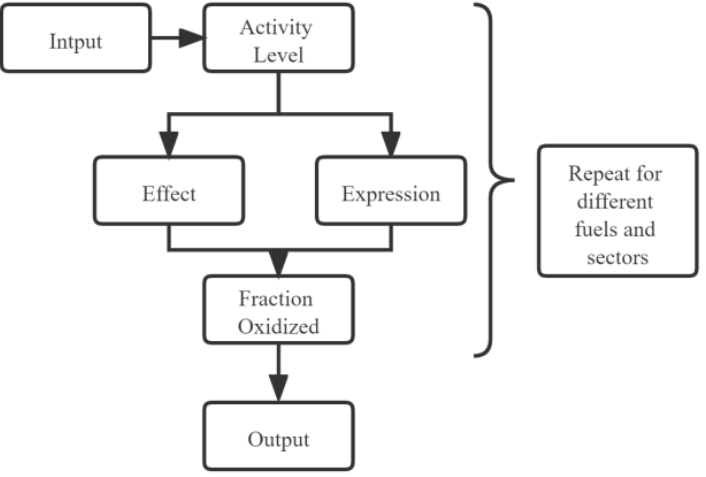
Figure 3. Application of formulations to the LEAP model (this figure was constructed for this study). Table 1. Calculation parameters for carbon emissions from energy consumption.